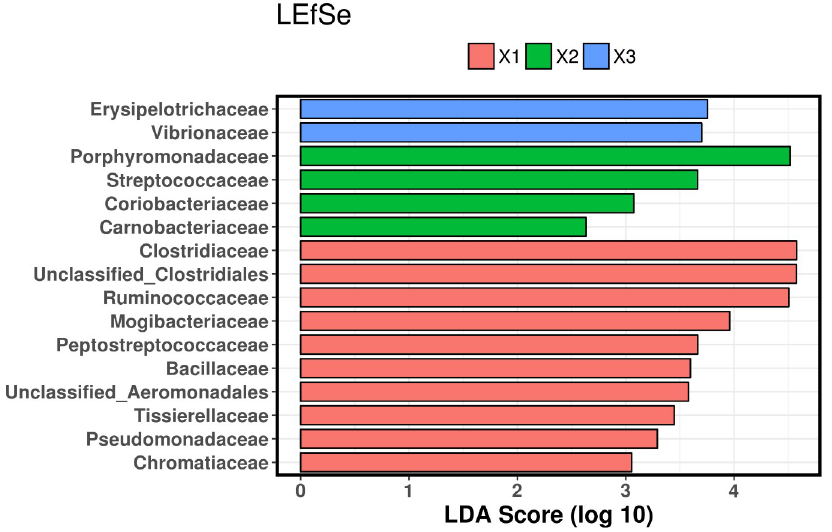
Fig 6. Linear discriminant analysis effect size (LEfSe) of bacterial families in feces from juvenile green turtles. Samples were collected at three time points throughout rehabilitation (X1 = admission, X2 = mid-rehabilitation, X3 =